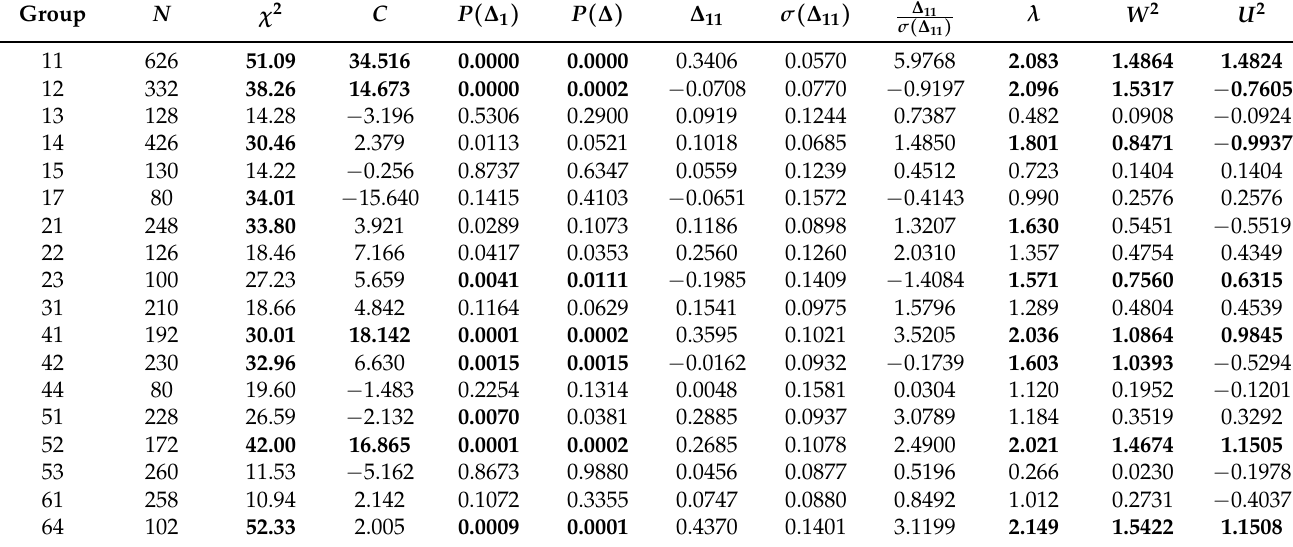
Table 12. Test for isotropy of the orientations of the galaxy plane. The distribution of the angle η of galaxies was obtained using the new “theoretical isotropic distribution” calculated for q 0 , depending on the morphological